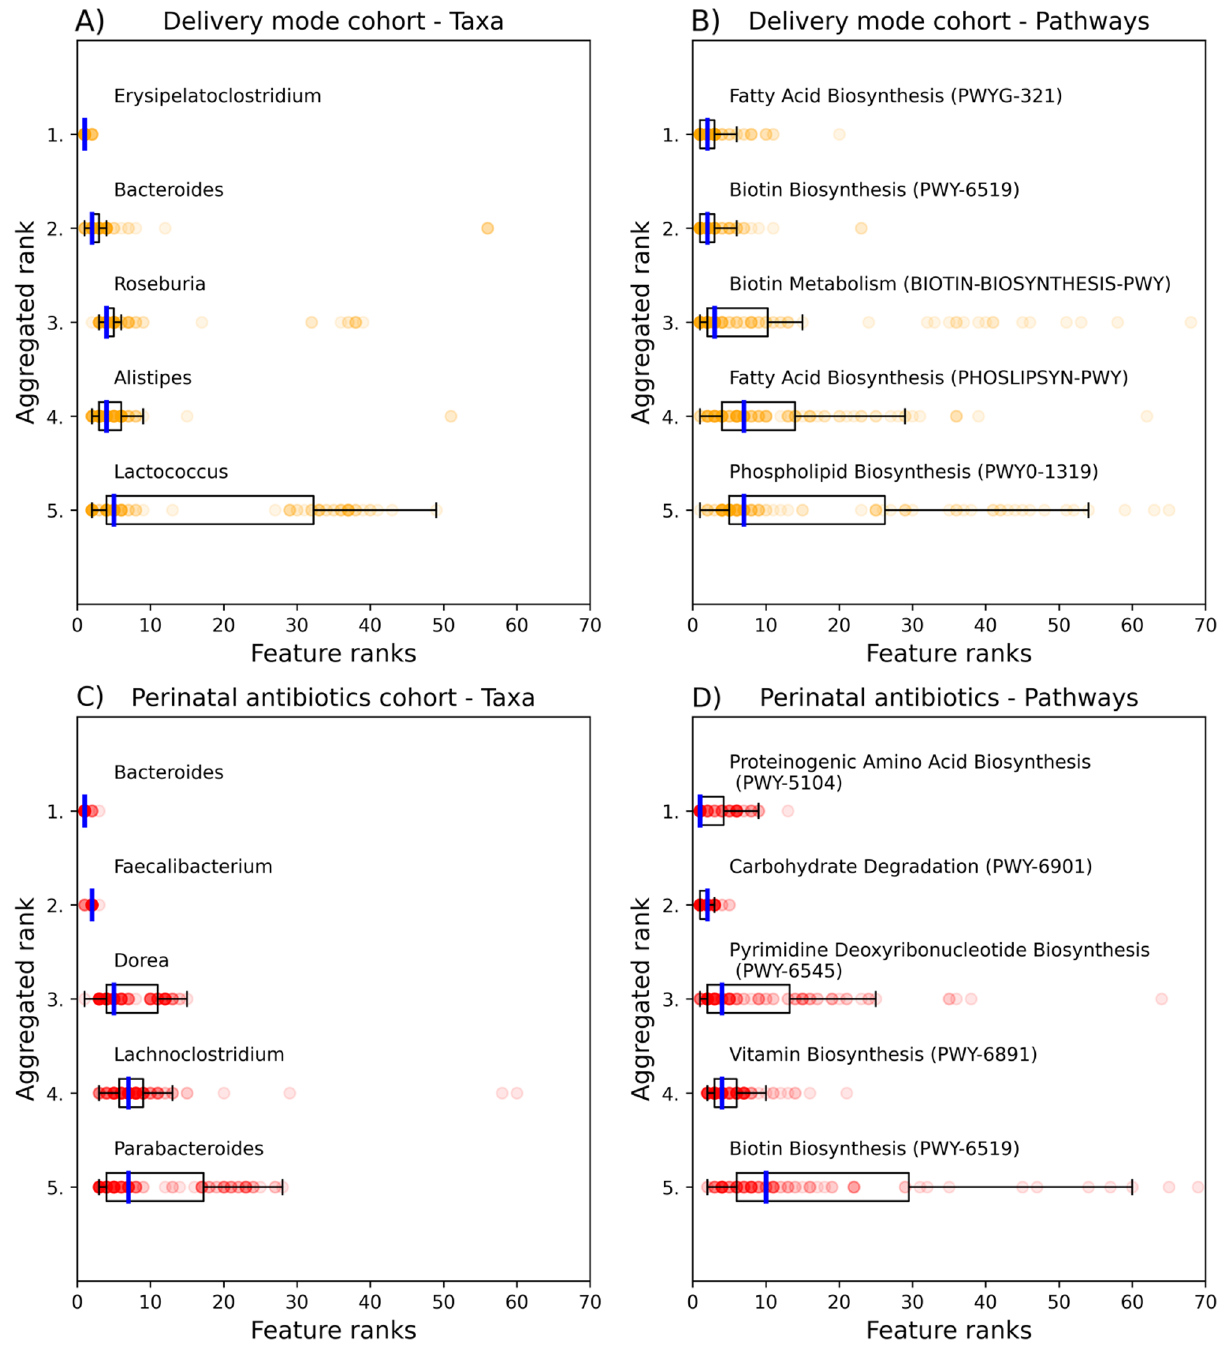
Figure 3. Feature importance rank aggregation analyses. Feature importance values from Random Forest, ExtraTrees and Adaboost machine learning models were transformed into rank values and aggregated together. Data from delivery mode cohort by ( A ) taxa and ( B ) pathways as well as perinatal antibiotics by ( C ) taxa and ( D ) pathways. The analysis was done to determine which features were important among all decision tree- based models. Model training was repeated 40 (red or yellow dots, 120 in total for each feature) times for each algorithm, and the ranks were gathered, and boxplots were drawn using the median. Median ranks were sorted in descending order from most important to the least important. Only the five most important features are shown for visualisation